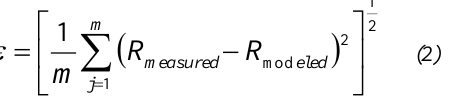
Figure 3. Pelalawan Fraction Model developed from several model fractions that has been studied previously as a parameter of land cover conditions in Pelalawan region consisted of land with a high peat content (wet) and dry land.